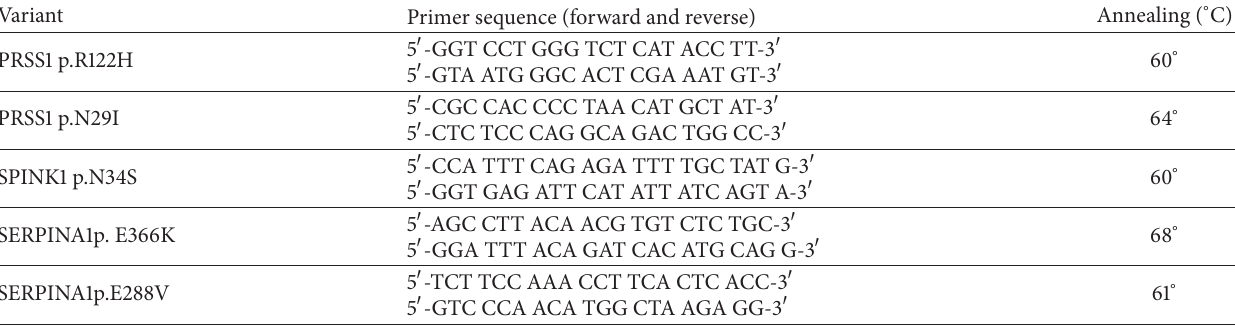
Table 1: Primer sequence and conditions for polymerase chain reaction-sequencing.